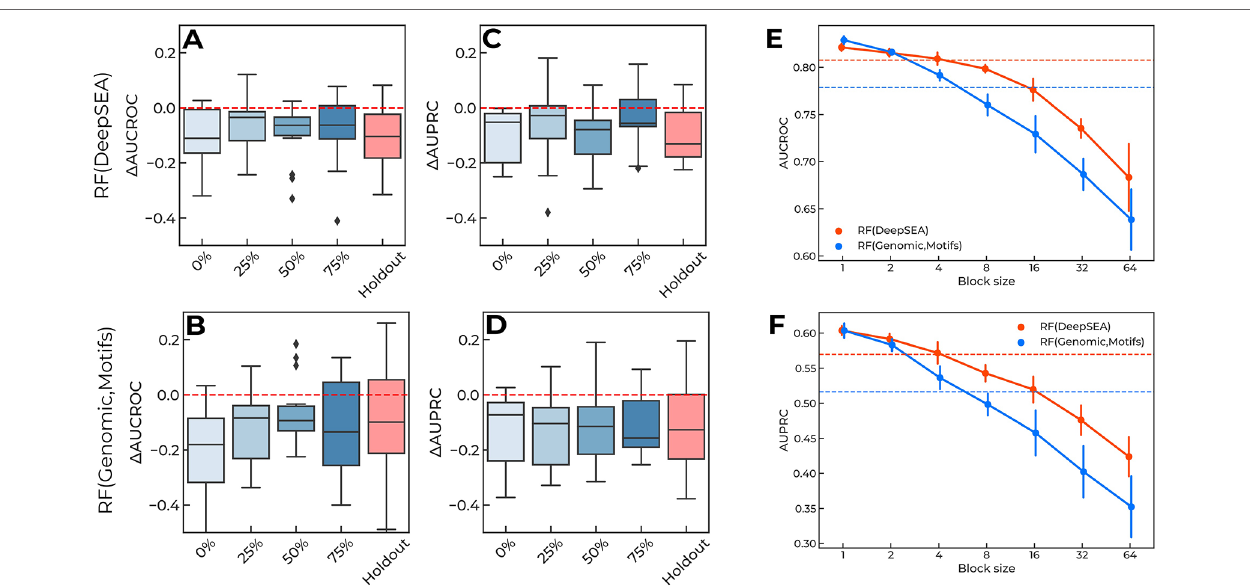
fiGURe 4 | (A-D) Training data of a single continuous block per reporter degrade performance of the prediction regulatory single-nucleotide variants (SNVs). X-axis, locations of training data blocks relative to the 5' ends of the reporters. Y-axis, the difference in AUCROC and AUPRC values for each model versus the baseline. The holdout of SNVs from each reporter is shown for the reference. Boxplots aggregate data from all reporters. Random Forest using DeepSEA features: (A) AUCROC, (C) AUPRC. Random Forest using genomic data and sequence motif features: (B) AUCROC, (D) AUPRC. (e – f) Shorter blocks in training data improve models performance due to information leakage. Orange lines: Random Forest classifier using DeepSEA features. Blue lines: Random Forest classifier using features based on genomic data and sequence motif analysis. Solid lines show the mean and standard deviation of 10 random samples with a fixed block length (X-axes). Dashed lines show the values reached in the original CAGI setup of the training data. (e) AUCROC values, (f) AUPRC values.